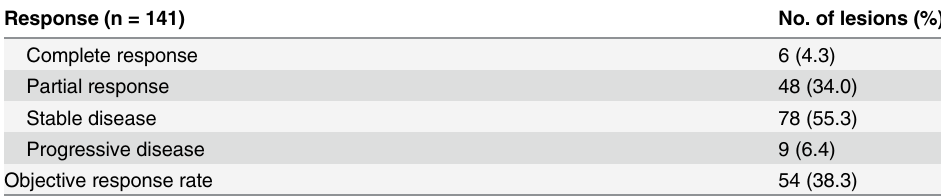
Table 2. Response rate after radiotherapy for adrenal metastasis from HCC.